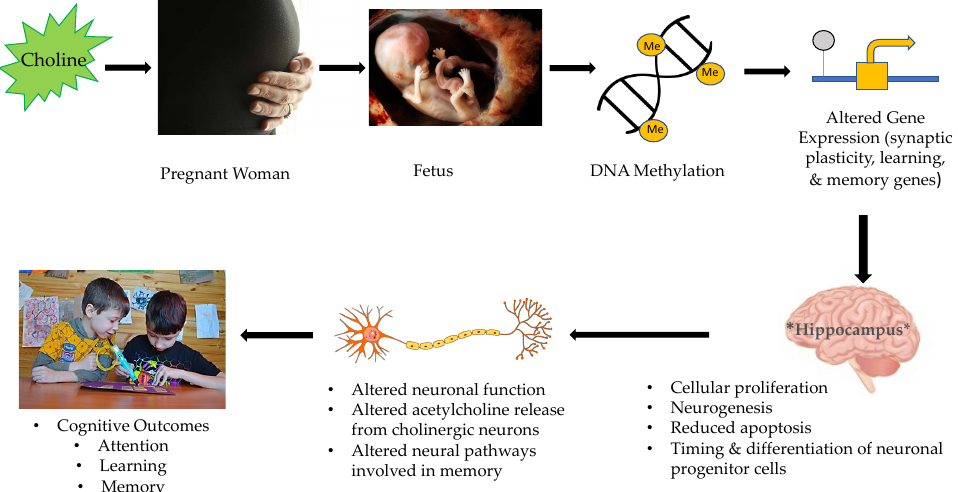
Figure 2. Potential mechanism of action through which prenatal choline affects brain and cognitive outcomes in